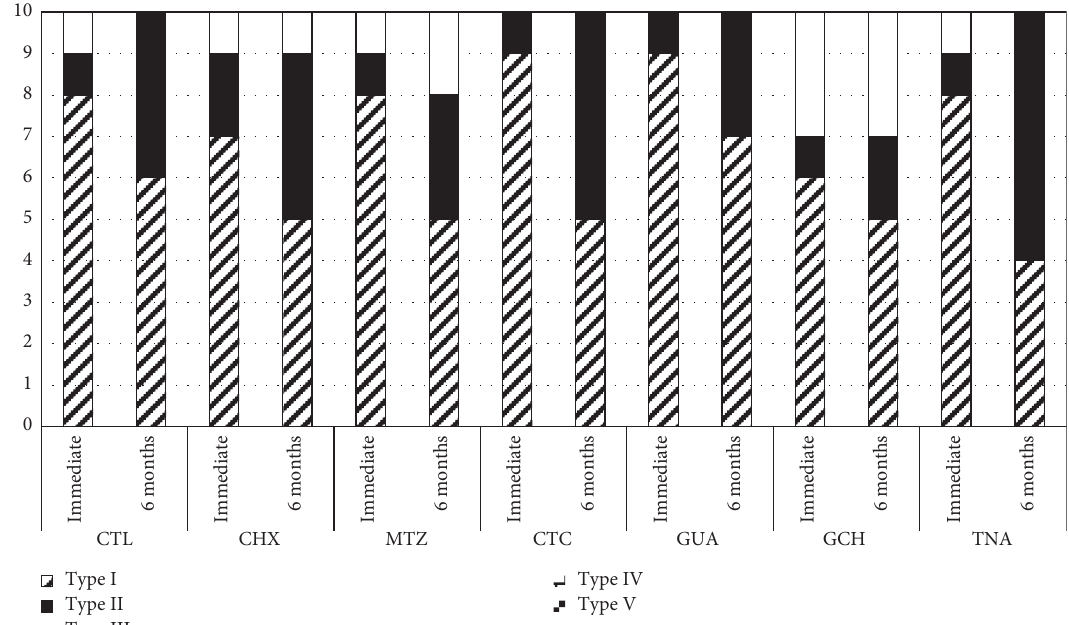
Figure 2: Incidence of failure modes (%) according to the experimental groups.